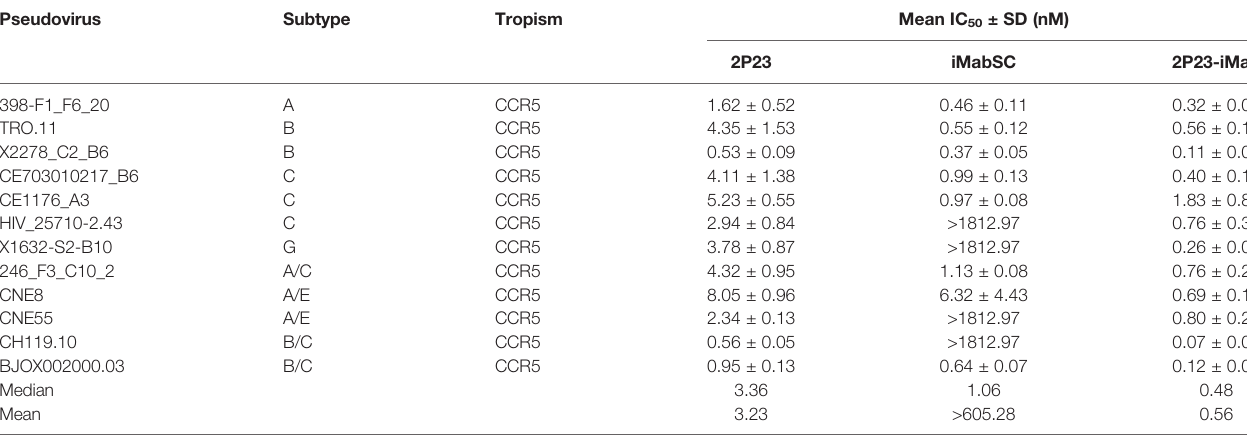
TABLE 1 | Inhibitory activities of 2P23-iMab and its template inhibitors against the “ global panel ” HIV-1 pseudoviruses.